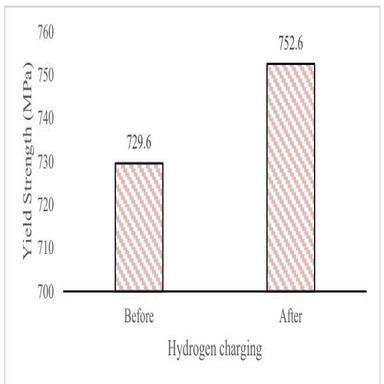
Effect of hydrogen charging on the yield strength of LPBF manufactured CrMnFeCoNi HEA .